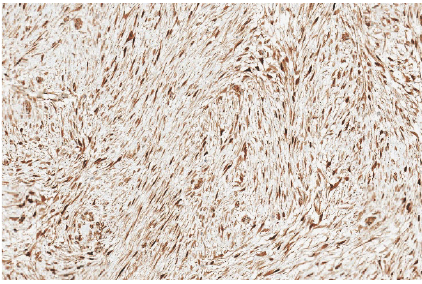
Figure 6: IHC stain for beta-catenin ( × 20) showing characteristic nuclear staining, confirming the diagnosis of